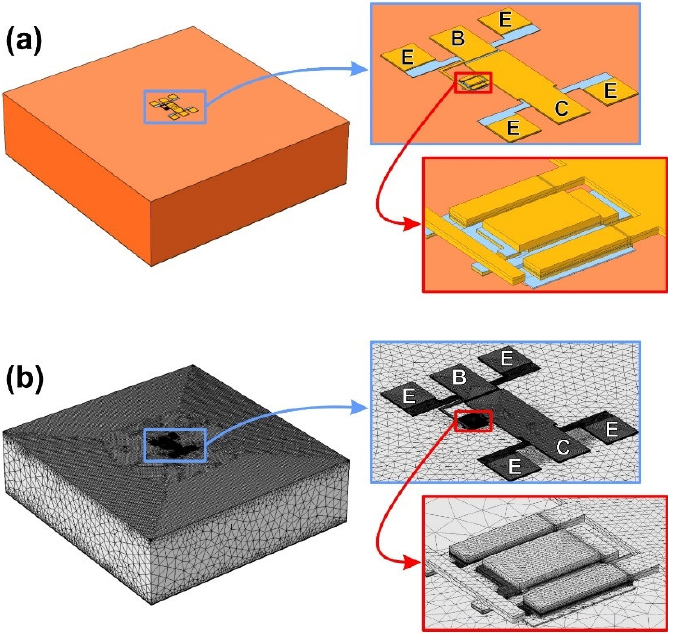
Figure 2. COMSOL environment: ( a ) geometry of the InGaP/GaAs HBT under test and ( b ) corre- sponding mesh.